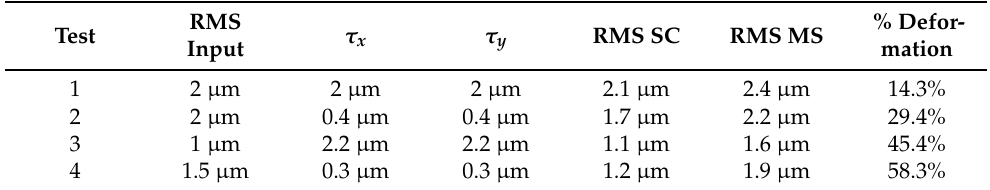
Table 1. Results for 4 tests with their respective initial values, (SC: surface created, MS: modified